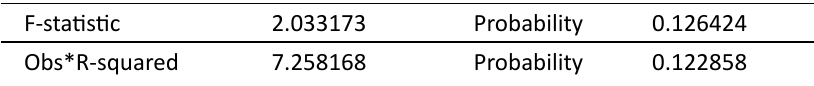
Table 4 : Heterocedasticity Test Result